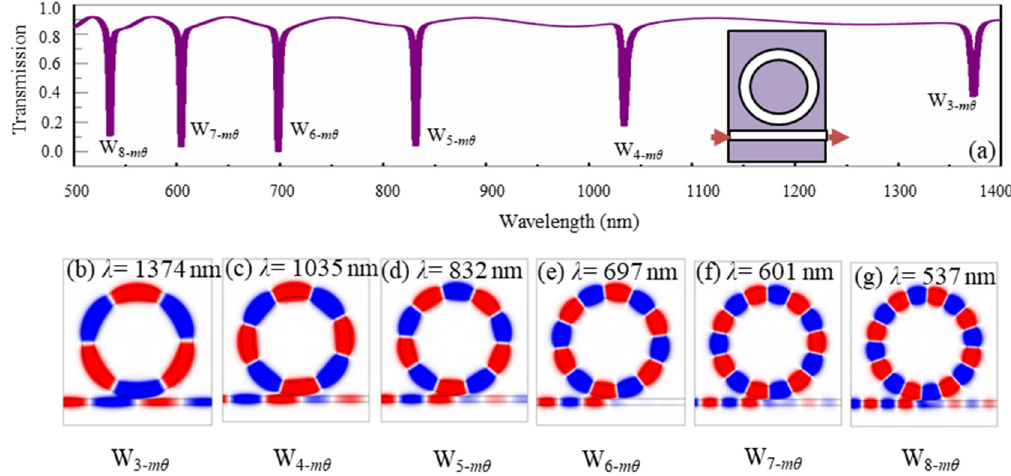
Figure 3. ( a ) The transmission of the ring waveguide coupled with a straight waveguide, and the H z -field distributions at the transmission dips of ( b ) W 3- m θ with λ = 1374 nm, ( c ) W 4- m θ with λ = 1035 nm, ( d ) W 5- m θ with λ = 832 nm, ( e ) W 6- m θ with λ = 697 nm, ( f ) W 7- m θ with λ = 601 nm, and ( g ) W 8- m θ with λ = 537 nm.